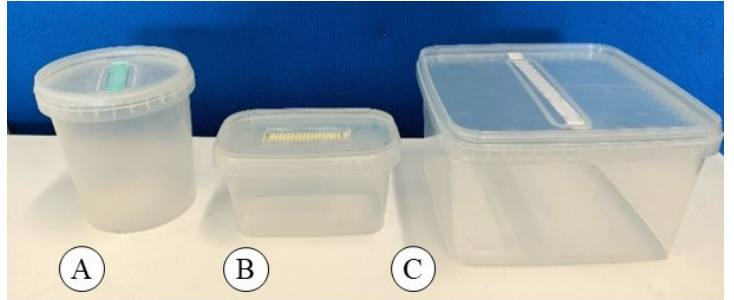
Figure 4. Plant containers used in the process. For the multiplication ( A ), for the root induction ( B ) and for the root expression and acclimatization phases ( C ).